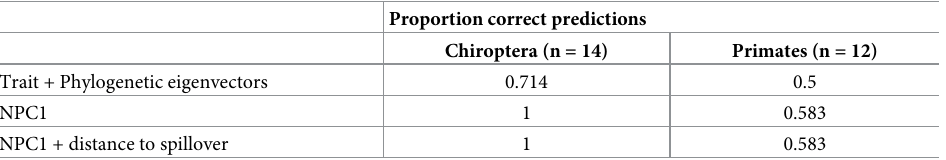
of bat cell lines [26] (S4 Table). Even models of NPC1 with nuisance variables of sampling effort and distance to spillover site still found significant positive infection in species with residue A at position 425 and marginal significance for other residues in positions 425–427 (S4 Table). Although our NPC1 models showed poor accuracy using leave-one-out cross val- idation (Table 1), these models predicted infection status of bats with 100% accuracy; whereas trait and phylogenetic models showed only 71% accuracy (Table 3) likely due to the low sensitivity of trait and phylogenetic eigenvector models for this group, meaning the abil- ity to identify a true positive infection status in bats is low (see S6 Table). For primates, the percent accuracy of all models was low at 50–58% (Table 3); however, the sensitivity of trait and phylogenetic eigenvectors models was 1 (S6 Table). Therefore, the low accuracy was due to low specificity (i.e., poor ability to identify a true negative infection status) for primates (S6 Table). Reservoir status predictions from our ridge regression models showed strong correlations to phylogenetic clades (Fig 2, see S2 Fig for visual comparison of predictions with raw data). The order Perissodactyla, families Ceropithecidae, Hominidae and Suidae showed high likeli- hood of death after exposure to Ebolavirus as well as high probability of past infection as esti- mated by antibody and PCR tests (Fig 2). We interpreted this category as ‘dead-end hosts’ unlikely to survive after exposure to Ebolavirus and therefore unlikely to sustain the pathogen for long periods of time in the wild; a criteria typically considered to be important for a species to serve as a ‘natural reservoir’ for a pathogen [11]. In contrast, fruit-eating bats in family Pter- opodidae showed high probability of past infection in antibody and PCR tests and are pre- dicted to have low mortality following exposure (Fig 2). Some members of Bovidae and Afrosoricida also fall into this category. We interpreted this group as potential ‘reservoirs’, rarely succumbing to infection and periodically serving as a source of infection for other hosts with higher mortality. Some species showed both low likelihood of being infected and low mortality even if exposed, which we interpreted as ‘low exposure and susceptibility’ (Fig 2); others showed low probability of infection but high mortality when exposed, which we inter- preted as species ‘susceptible but rarely exposed’ to ebolaviruses (Fig 2). These predictions, however, are based on our trait and phylogenetic eigenvector models which has uneven pre- diction accuracy across clades (S6 Table). Table 3. Proportion of correct predictions for species in orders Chiroptera and Primates made by three compet- ing models, namely trait and phylogenetic eigenvector model, NPC1 sequence model, and NPC1 model with dis- tance to spillover and sampling effort variables